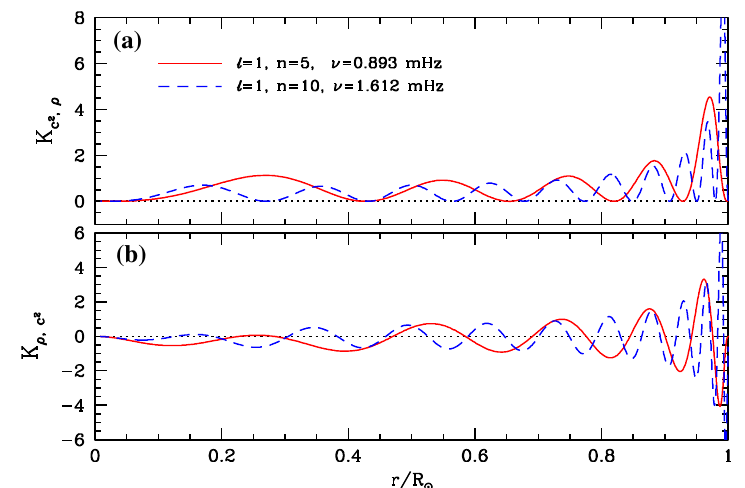
Fig. 10 Sound-speed kernels ( a ) and density kernels ( b ) for modes of the same degree but different radial orders (and hence frequencies)